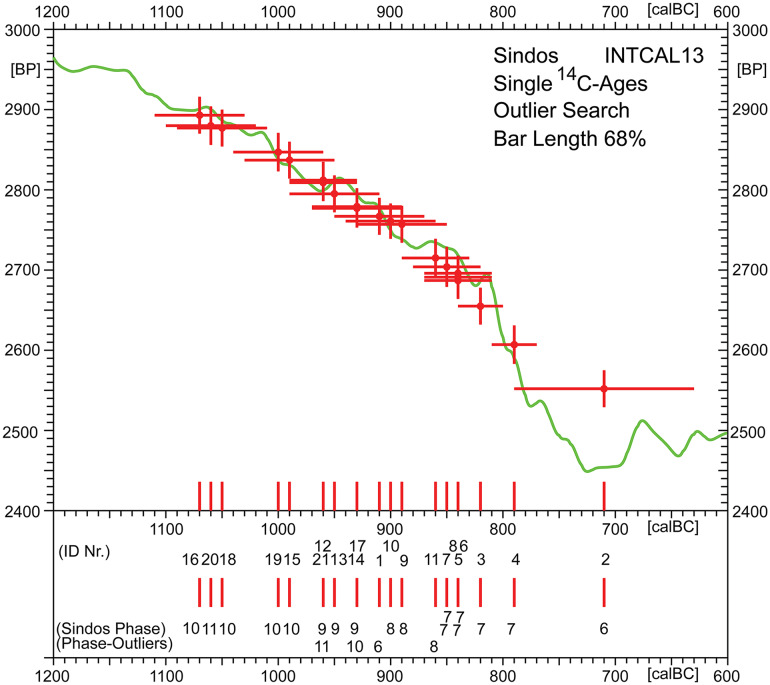
Overview of radiocarbon ages from Sindos (N = 21; Table 1).